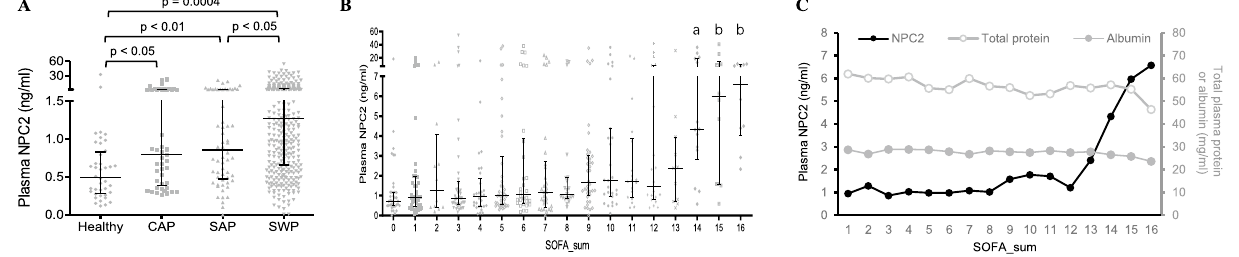
Figure 2. Concentration of the Niemann–Pick disease type C2 protein (NPC2) in human plasma. The concentration of plasma NPC2 was determined by ELISA. ( A ) Comparisons of plasma NPC2 concentrations in healthy subjects, and patients of community-acquired pneumonia (CAP), sepsis-associated pneumonia (SAP) and sepsis with comorbid pneumonia (SWP). ( B ) Comparisons of plasma NPC2 concentrations in pneumonia (SOFA = 0 or 1) and sepsis patients (SOFA ≥ 2) with different SOFA scores. a: p < 0.001 versus the group of SOFA_sum = 0; b: p < 0.01 versus the group of SOFA_sum = 0. ( C ) Concentrations of total protein, albumin and NPC2 in plasma from pneumonia (SOFA = 1) and sepsis patients (SOFA ≥ 2) with different SOFA scores. The Kruskal–Wallis ANOVA test followed by the Dunn’s test was used. All p values reflect a two-tailed